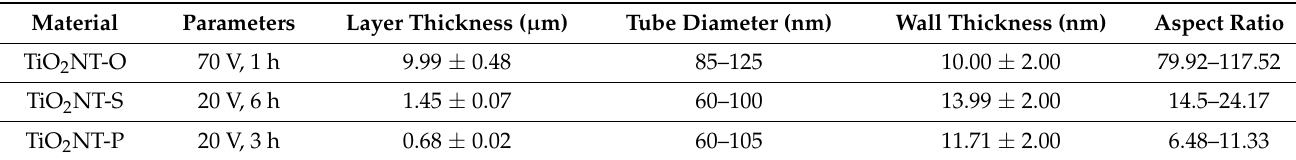
Table 1. Summary of the topological features of the nanotube